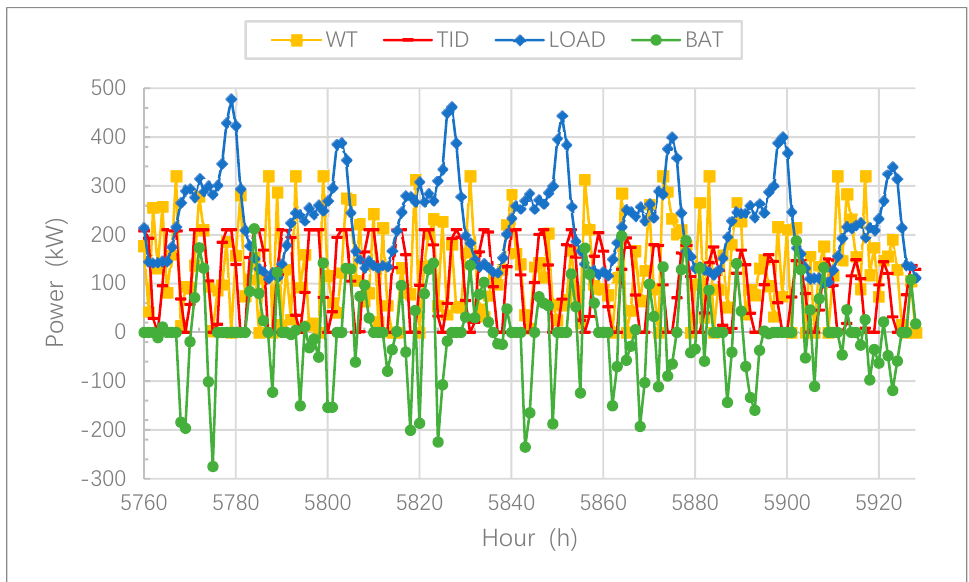
Figure 14. Annual electricity generation of renewable energy system.